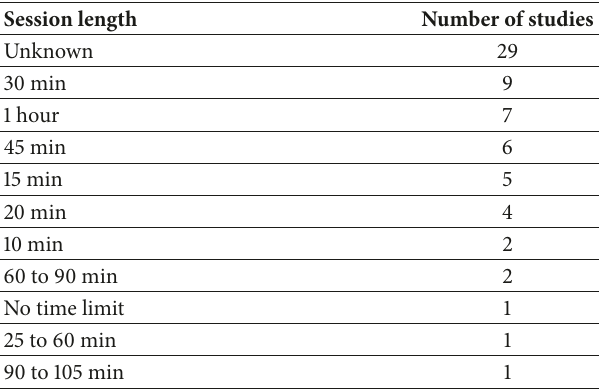
Table 11: Session length in included studies.